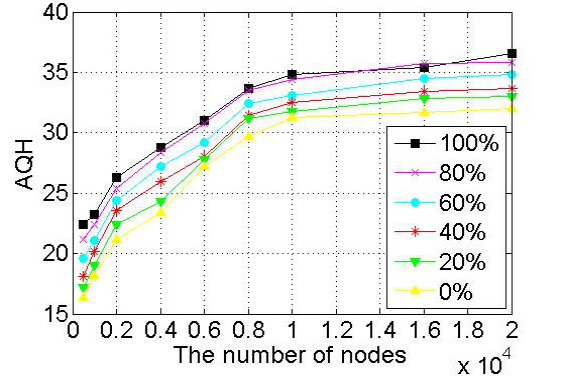
Figure 9. The AQH for SPEQs and the number of nodes.